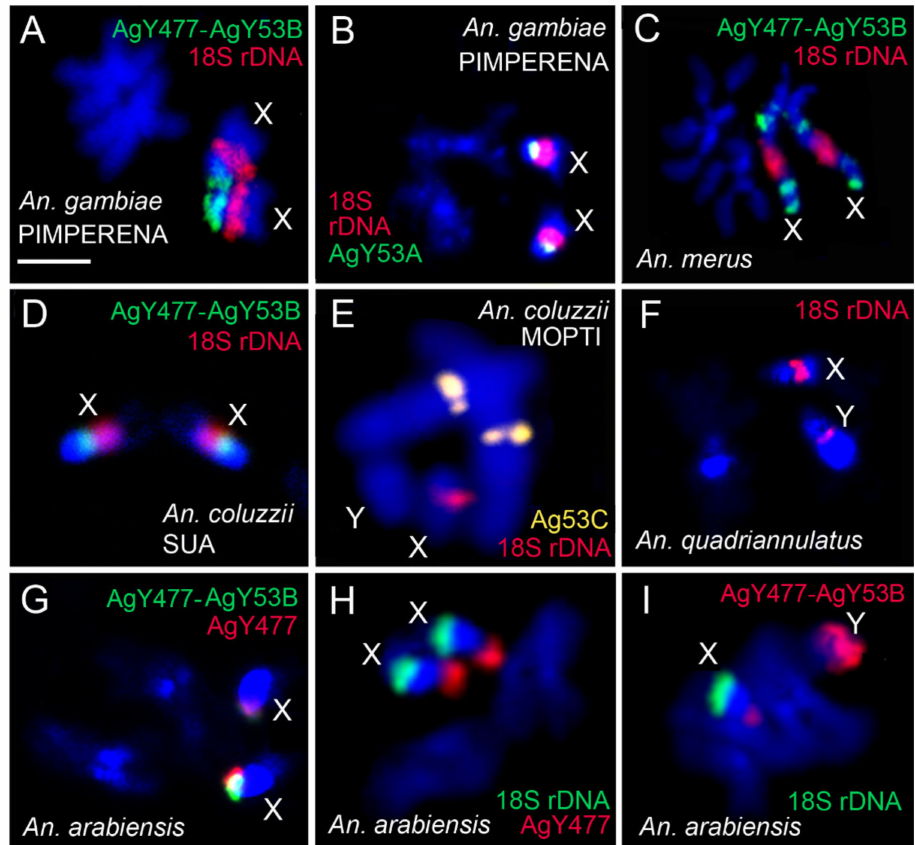
Figure 4. Mapping of repetitive DNA elements to mitotic chromosomes of species from the An. gambiae complex. ( A ) FISH of AgY477–AgY53B (green) and 18S rDNA (red) in An. gambiae PIMPERENA. ( B ) FISH of satellite AgY53A (green) and 18S rDNA (red) in An. gambiae PIMPERENA. ( C ) FISH of AgY477–AgY53B (green) and 18D rDNA (red) in An. merus . ( D ) FISH of AgY477–AgY53B (green) and 18S rDNA (red) in An. coluzzii SUA. ( E ) FISH of satellite Ag53C (yellow) and 18D rDNA (red) in An. coluzzii MOPTI. ( F ) FISH of 18S rDNA (red) in An. quadriannulatus . ( G ) FISH of satellite AgY477 (red) and AgY477–AgY53B (green) in An. arabiensis . ( H ) FISH of satellite AgY477 (red) and 18D rDNA (green) in An. arabiensis . ( I ) FISH of 18S rDNA (green) and AgY477–AgY53B (red) in An. arabiensis . Scale bar = 2 µ